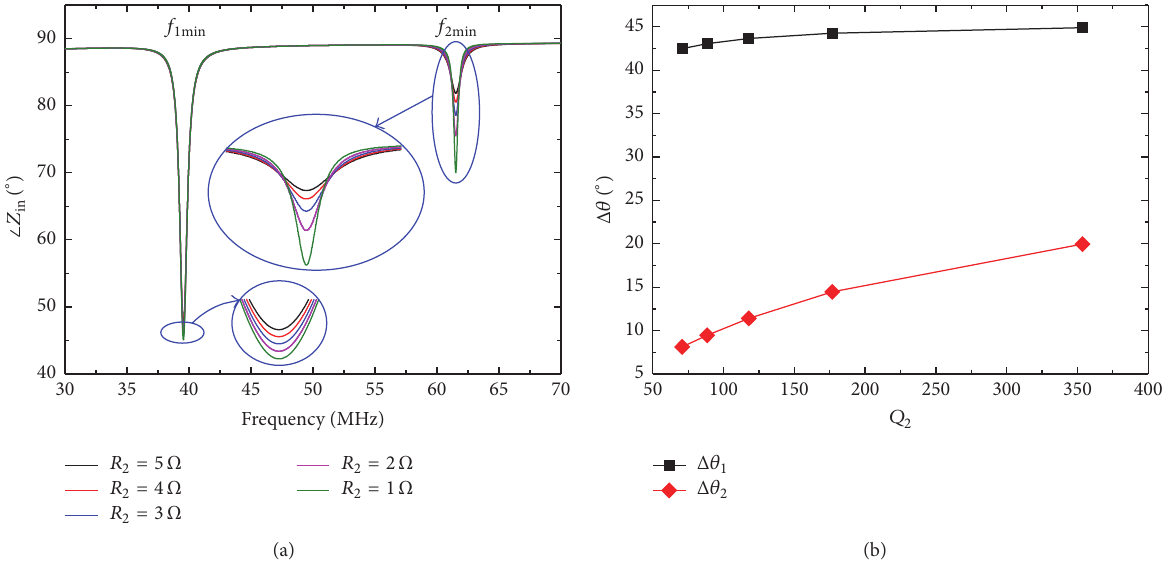
Figure 6: (a) Phase versus frequency curve of the readout coil when the 𝑄 factor 𝑄 2 increased and (b) the influence of 𝑄 2 on the value of Δ𝜃 1 and Δ𝜃 2